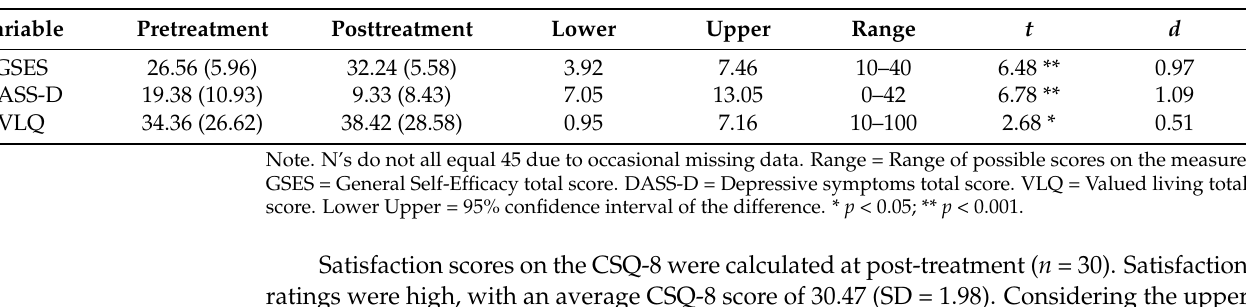
Table 3. Descriptivestatisticsandchangesinpsychosocialhealthoutcomesfrompretreatmentto